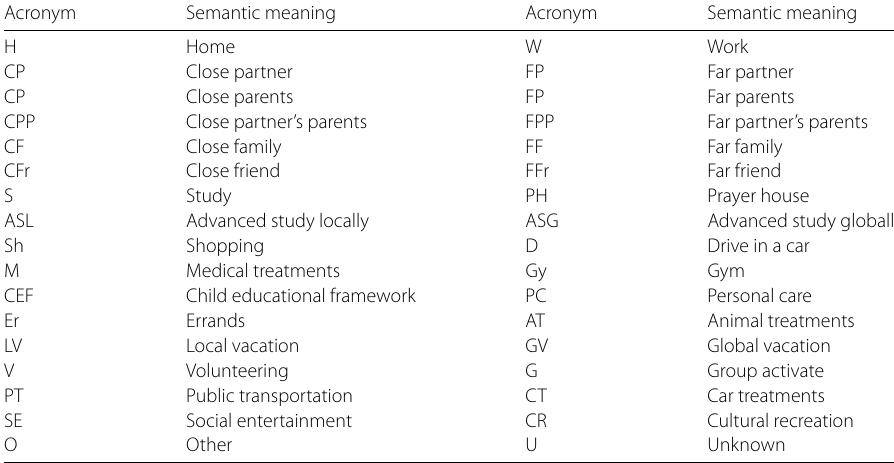
Table 1 The semantic meaning vocabulary of 34 POIs determined based on all POIs identified for 38 users participating in the experiment. “Close” is in the same city and “Far” is in a different city. “Local” is in the same country and “Global” is in a different country Acronym Semantic meaning Acronym Semantic meaning